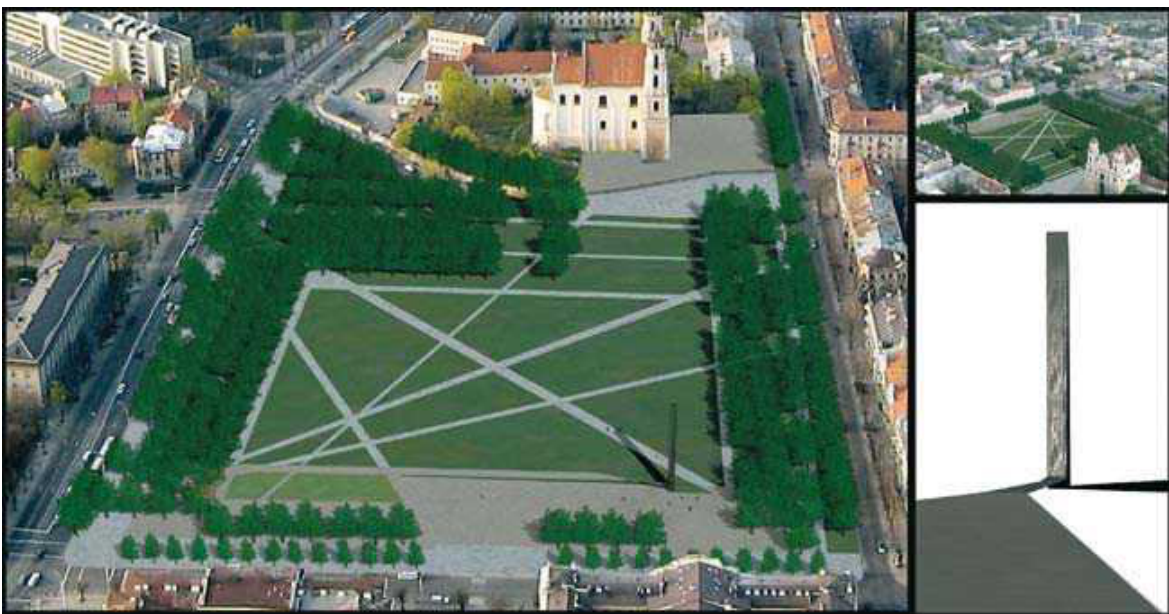
Fig. 4. Architectural competition for Lukiškės Square and symbol “Freedom“,